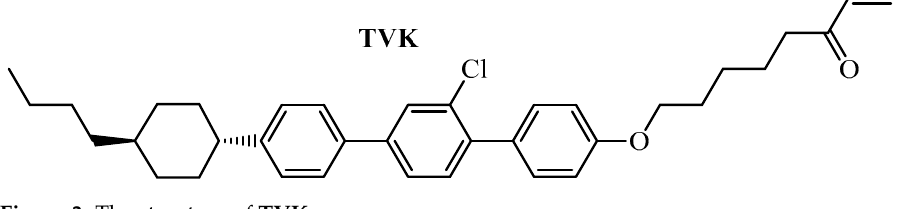
Figure 3. The structure of TVK .